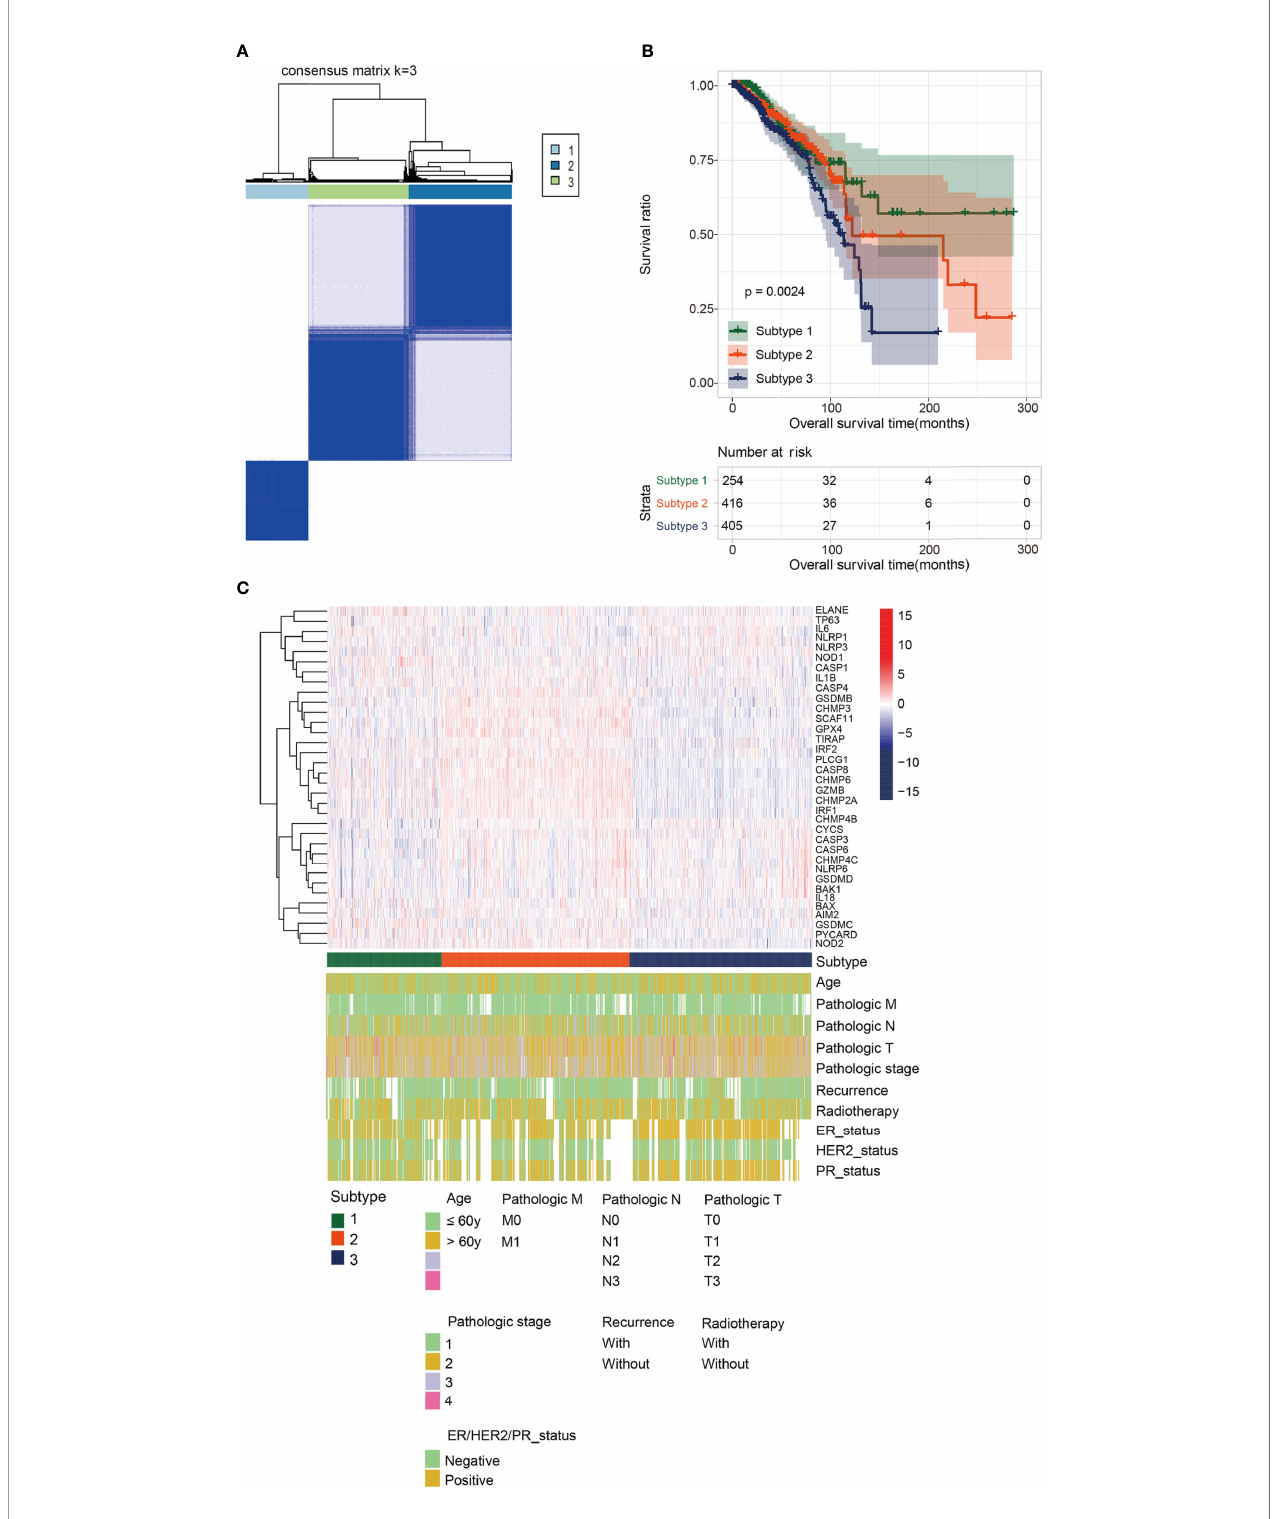
FIGURE 3 | Subtype analysis. (A) Cluster diagram for subtype analysis of breast cancer samples. The intragroup correlations were the highest and the inter-group correlations were low when k=2. (B) The Kaplan-Meier analysis for the three different subtypes. Subtype 1 had the best prognosis, while Subtype 3 had the worst prognosis. (C) The distribution map of pyroptosis- related genes and clinicopathologic characters in the three